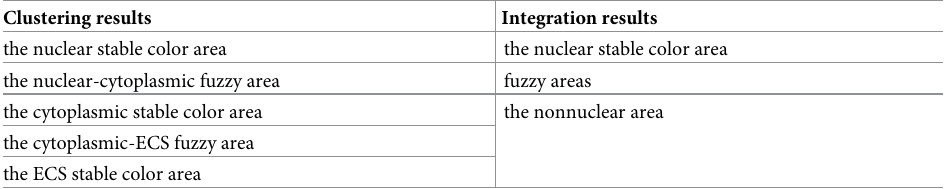
Fig 2. Comparison of the ground truth and clustering results of nuclei. Where the olive areas indicate the stable color areas of the nuclei in the clustering result, and the green outlines indicate ground truths of the nuclear stable color area. https://doi.org/10.1371/journal.pone.0263006.g002 Table 1. Comparison results before and after integration of each category.